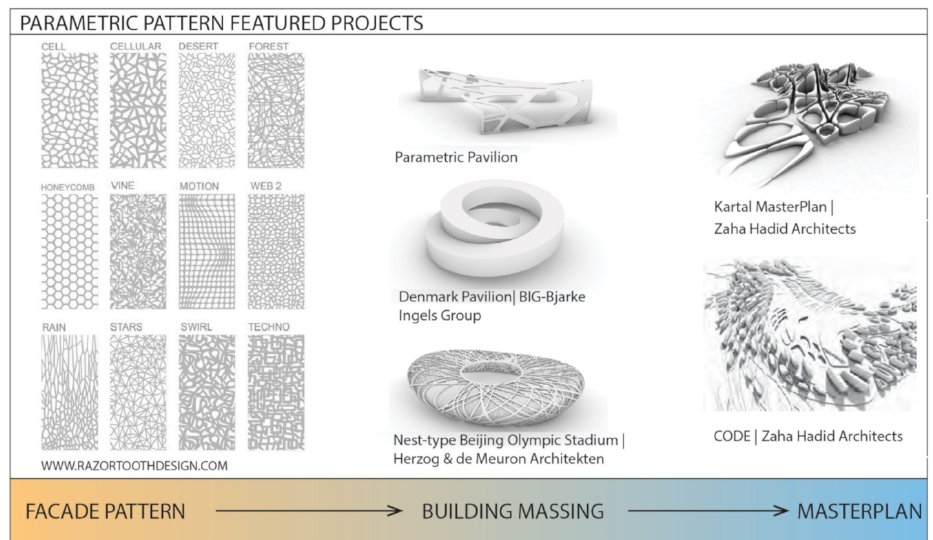
Figure 2. Parametric pattern featured